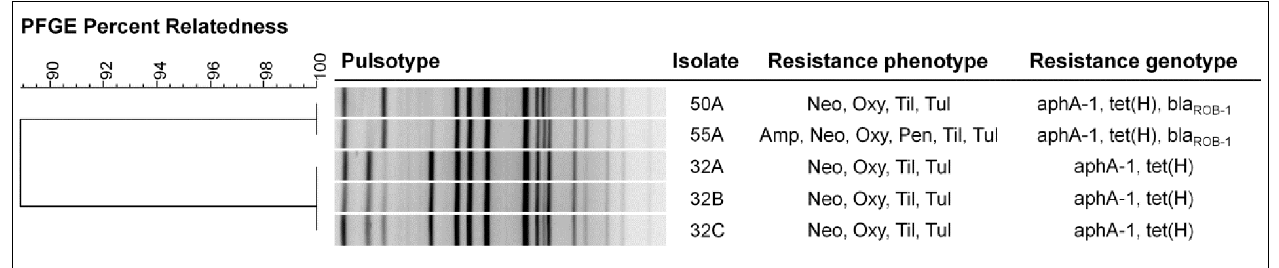
and tolerance settings of 1.0 and 1.5%, respectively. Resistance genotype was based on detection of resistance genes by PCR. Neo, neomycin; Oxy, oxytetracycline; Til, tilmicosin; Tul, tulathromycin, Amp,